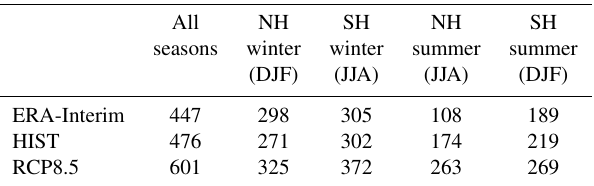
Table 1. Number of WCB trajectories per 6h interval for ERA- Interim, HIST, and RCP8.5, determined as an average for the 37 ERA-Interim and 50 CESM years. The different columns give the global and yearly average (column 2), the winter averages for the Northern Hemisphere (NH) and Southern Hemisphere (SH) (columns 3 and 4), and correspondingly the summer averages (columns 5 and